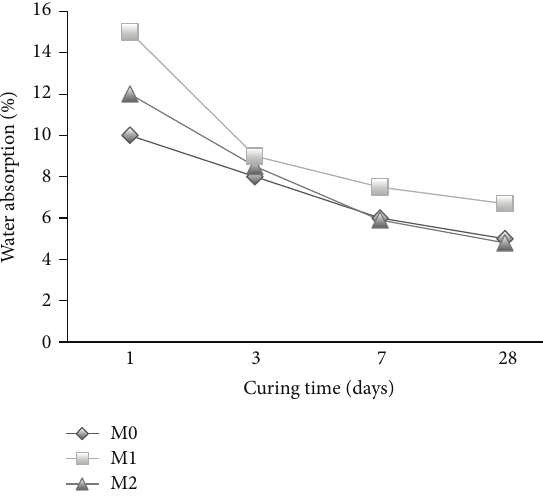
Figure 5: The effect of cosurfactants on the water absorption of